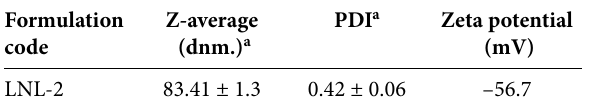
Table 2. Determination of Z-average, Poly dispersive index (PDI) and zeta potential of the selected formulation Formulation